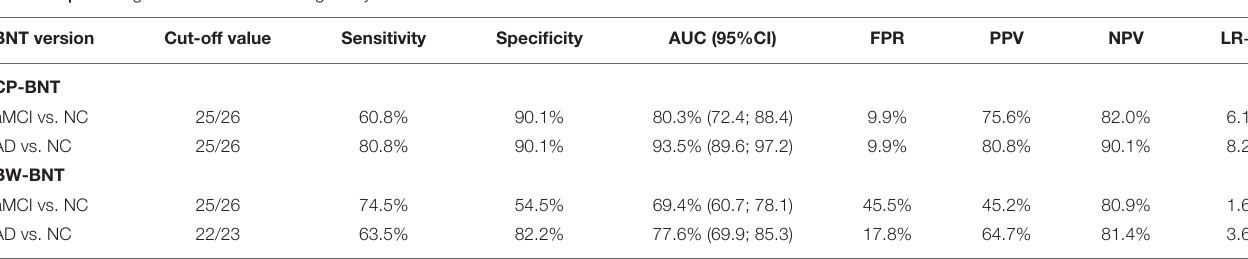
TABLE 2 | The diagnostic and differentiating ability of CP-BNT and